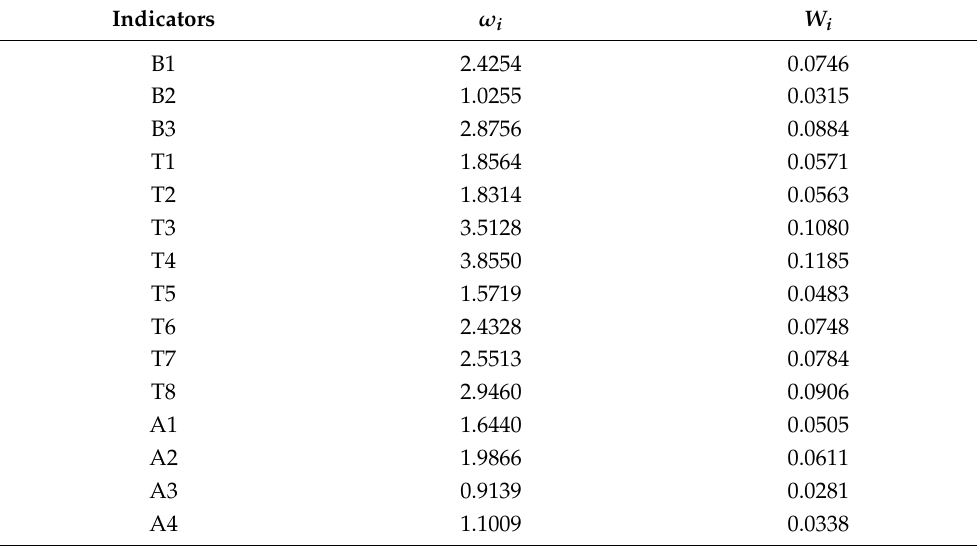
Table 5. The importance and normalized weights of performance indicators of